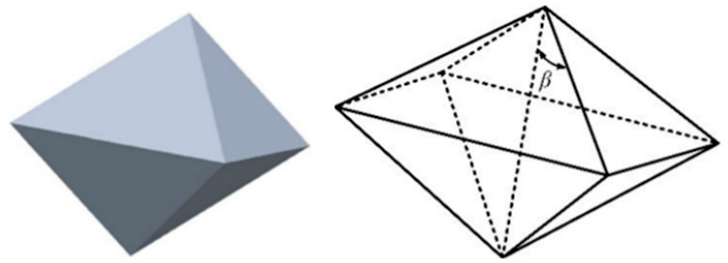
Figure 7. Semi-angle between two opposite edges of abrasive grain.